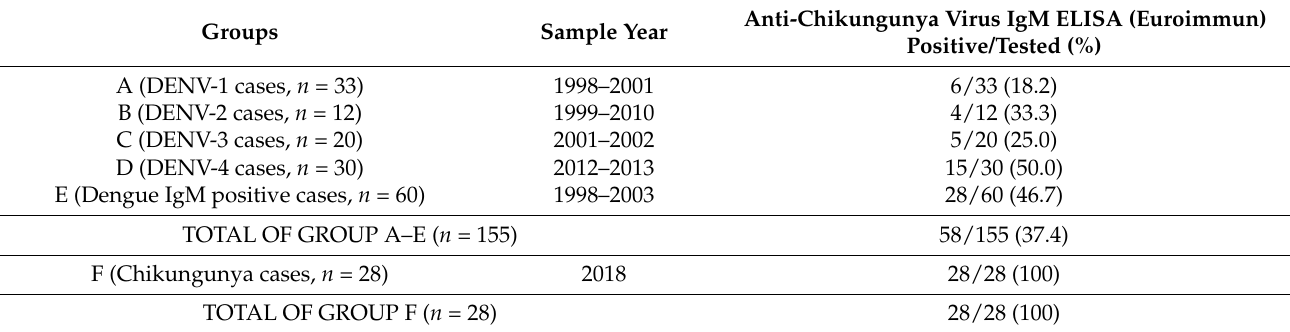
Table 1. Evaluation of the Anti-chikungunya IgM ELISA (Euroimmun) for chikungunya diagnosis based on the analysis of the distinct